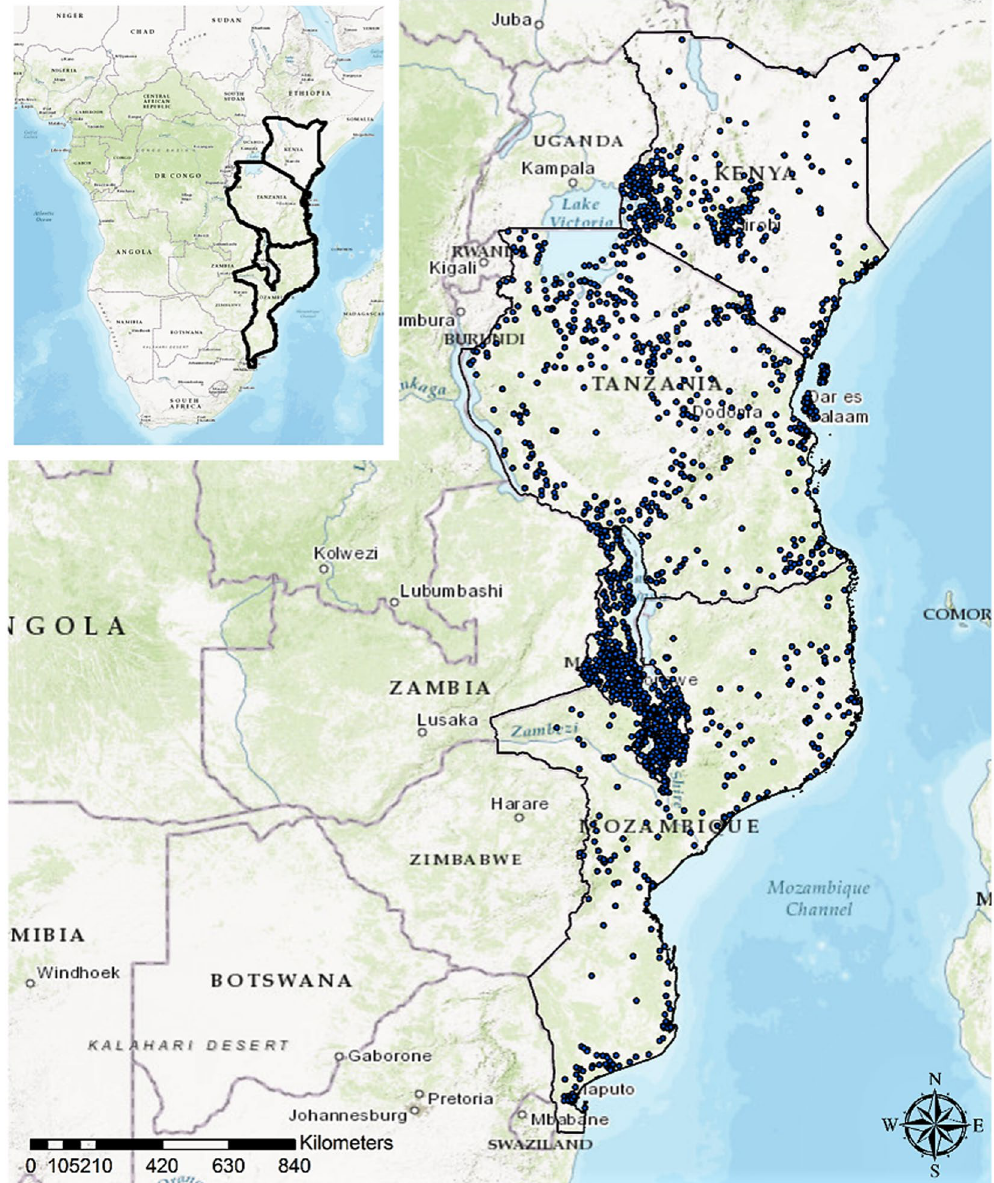
Figure 1. The overall study area (top right panel) and Demographic and Health Survey (DHS) sample locations (blue dots) for each country included in the study. Maps were created using ArcGIS ® software by Esri version 10.3 42